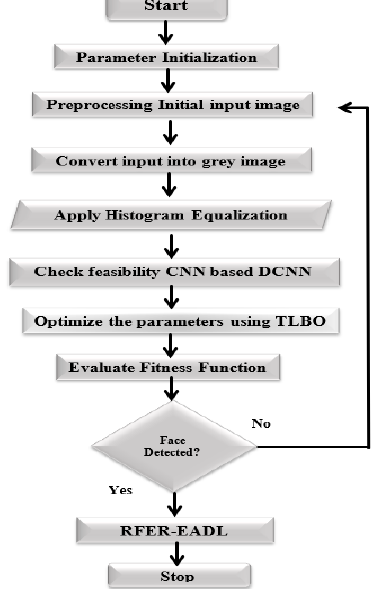
Figure 3. RFER- EADL’s process. Figure 3. RFER-EADL’s